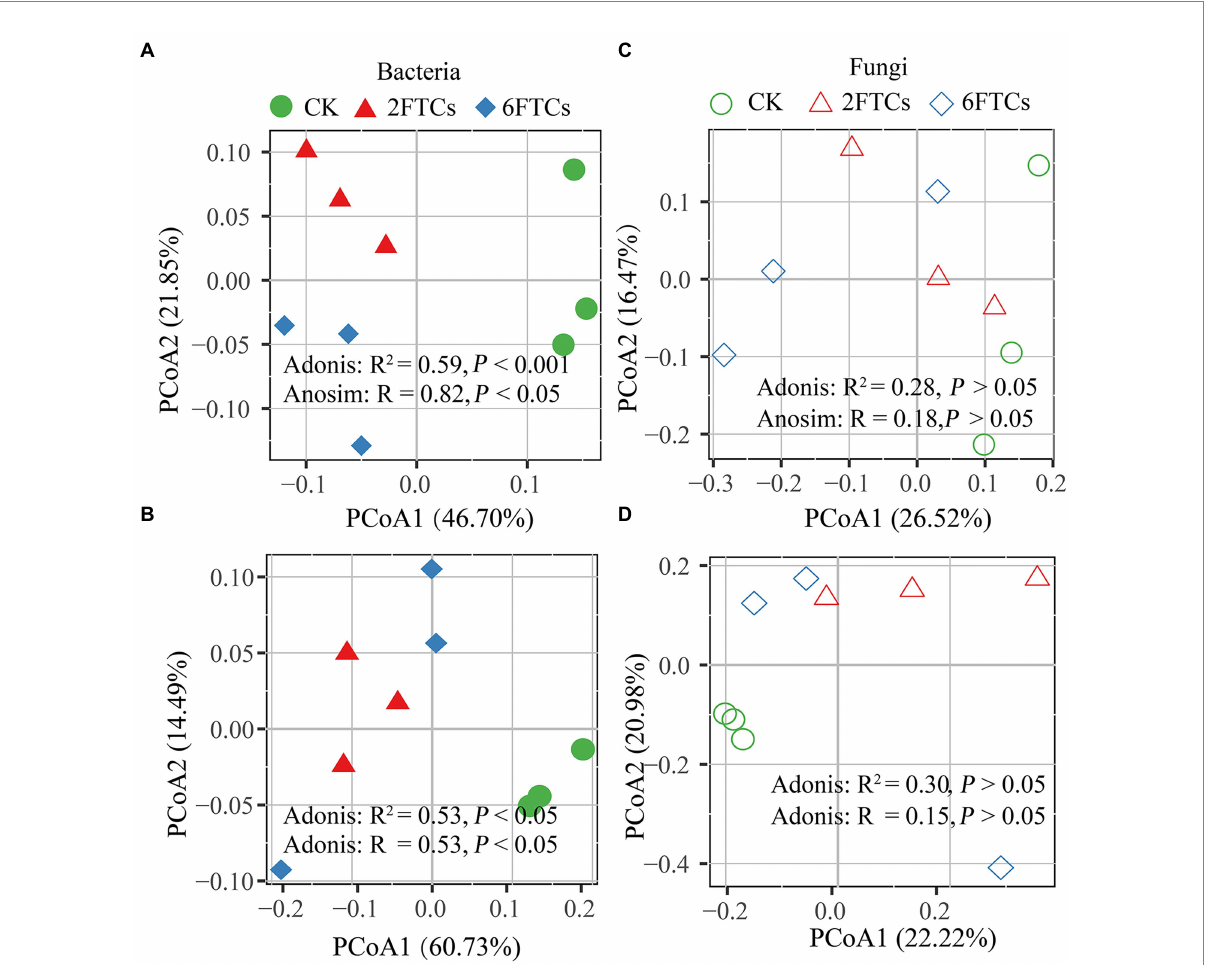
FIGURE 4 PCoA analysis of the bacterial community composition in (A) 0–10 cm; (B) 50–60 cm, and the fungal community composition in (C) 0–10 cm; (D) 50–60 cm based on the Bray-Curtis distance in different freeze–thaw treatments. CK, 2FTCs, and 6FTCs represent culture at 5 ° C, two freeze– thaw cycles, and six freeze–thaw cycles,